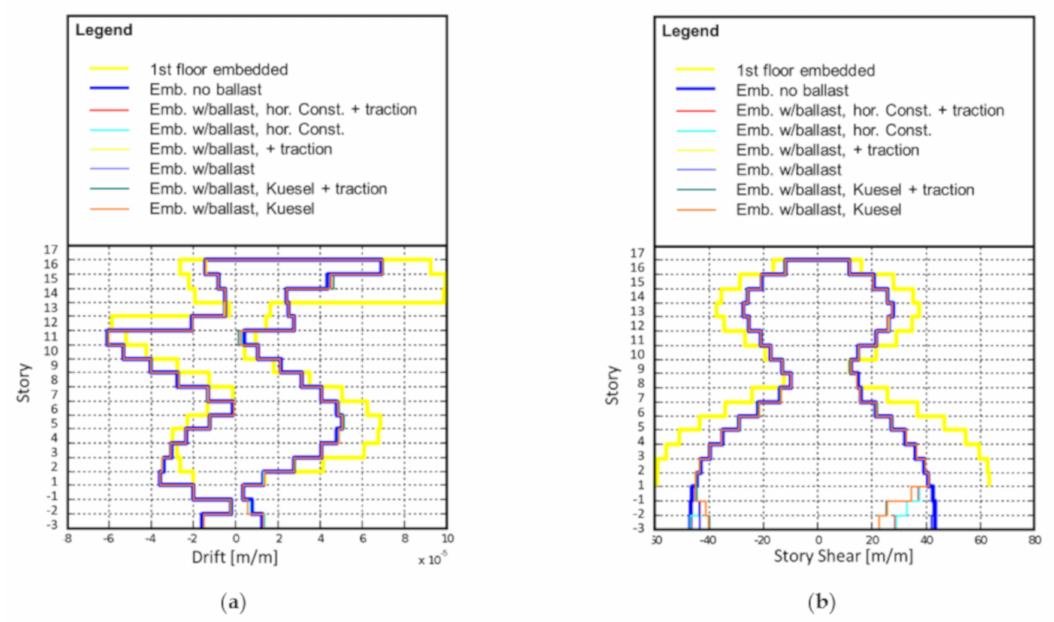
Figure 14. ( a ) Inter-story drifts in the Y -axis (event 12). ( b ) Inter-story shear forces in the Y -axis (event